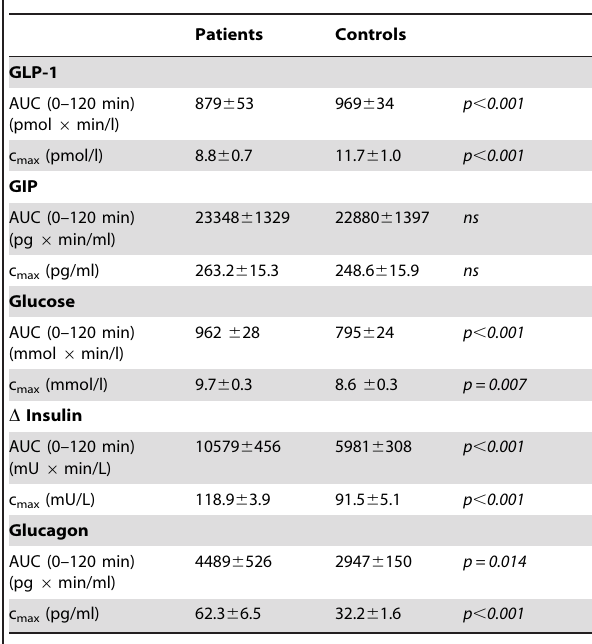
Table 2. Secretion of Glucagon-like peptide-1 (GLP-1), Glucose-dependent insulinotropic polypeptide (GIP), insulin and glucagon and glucose disposal in patients with NAFLD and NASH vs. controls in response to oral glucose tolerance